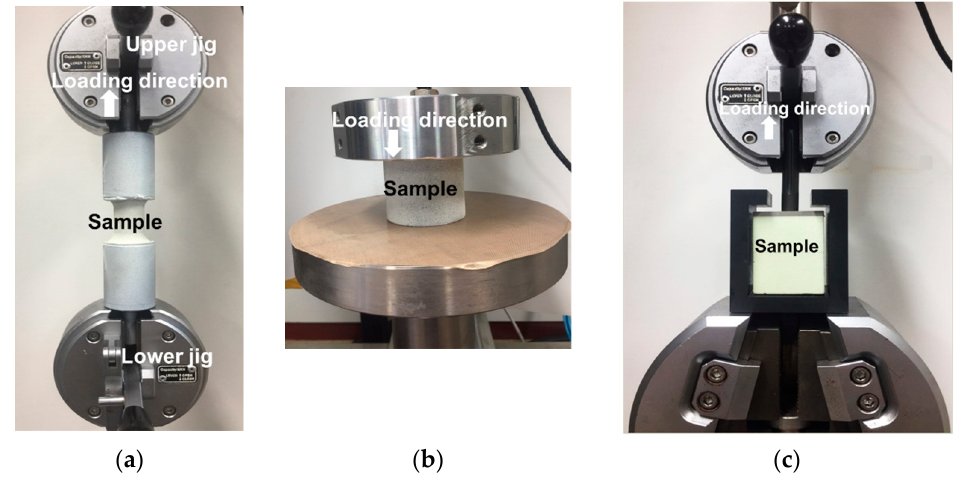
Figure 3. Experimental set-up for: ( a ) tensile test; ( b ) compressive test; ( c ) pull-out test.